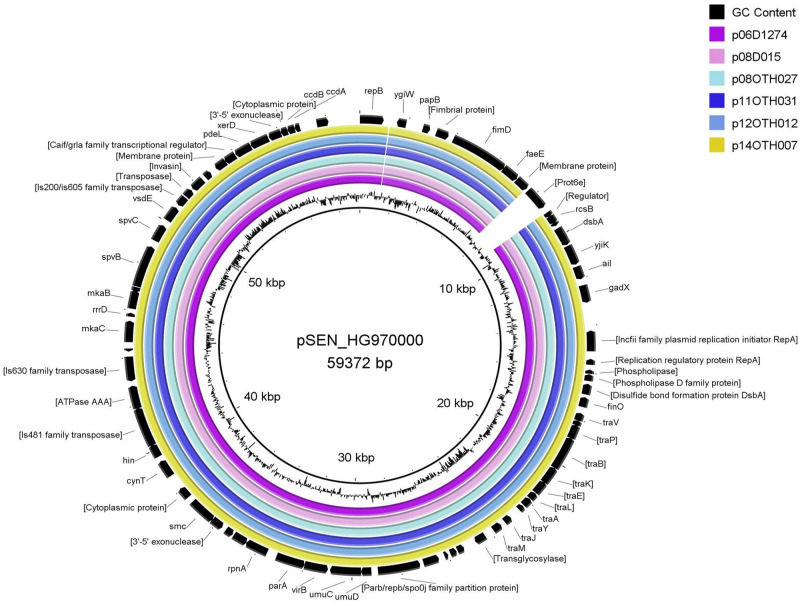
BRIG diagram comparing unusual S. Enteritidis plasmid sequences with that of the reference plasmid pSEN. Colored rings represent 100% similarity to the reference sequence.